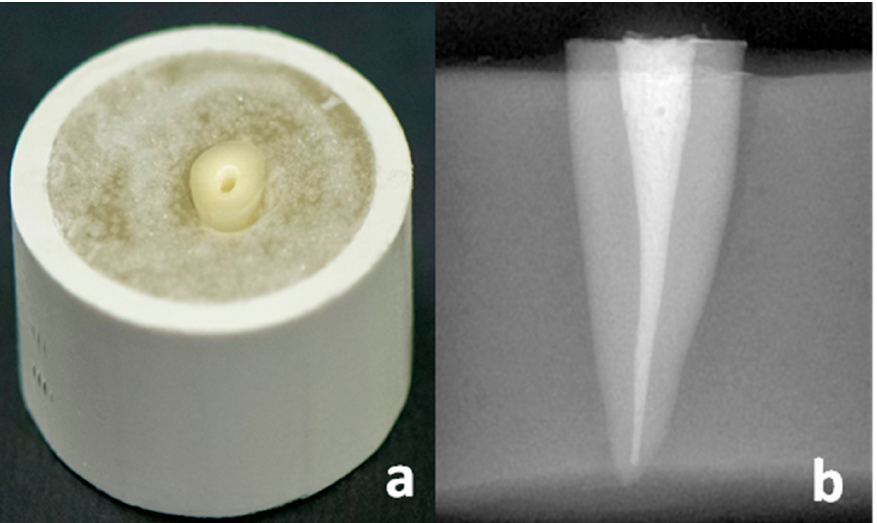
Figure 1. ( a ): Mounted tooth specimen sectioned at cemento-enamel junction; ( b ): Radiograph of specimen after endodontic treatment and before post space preparation.